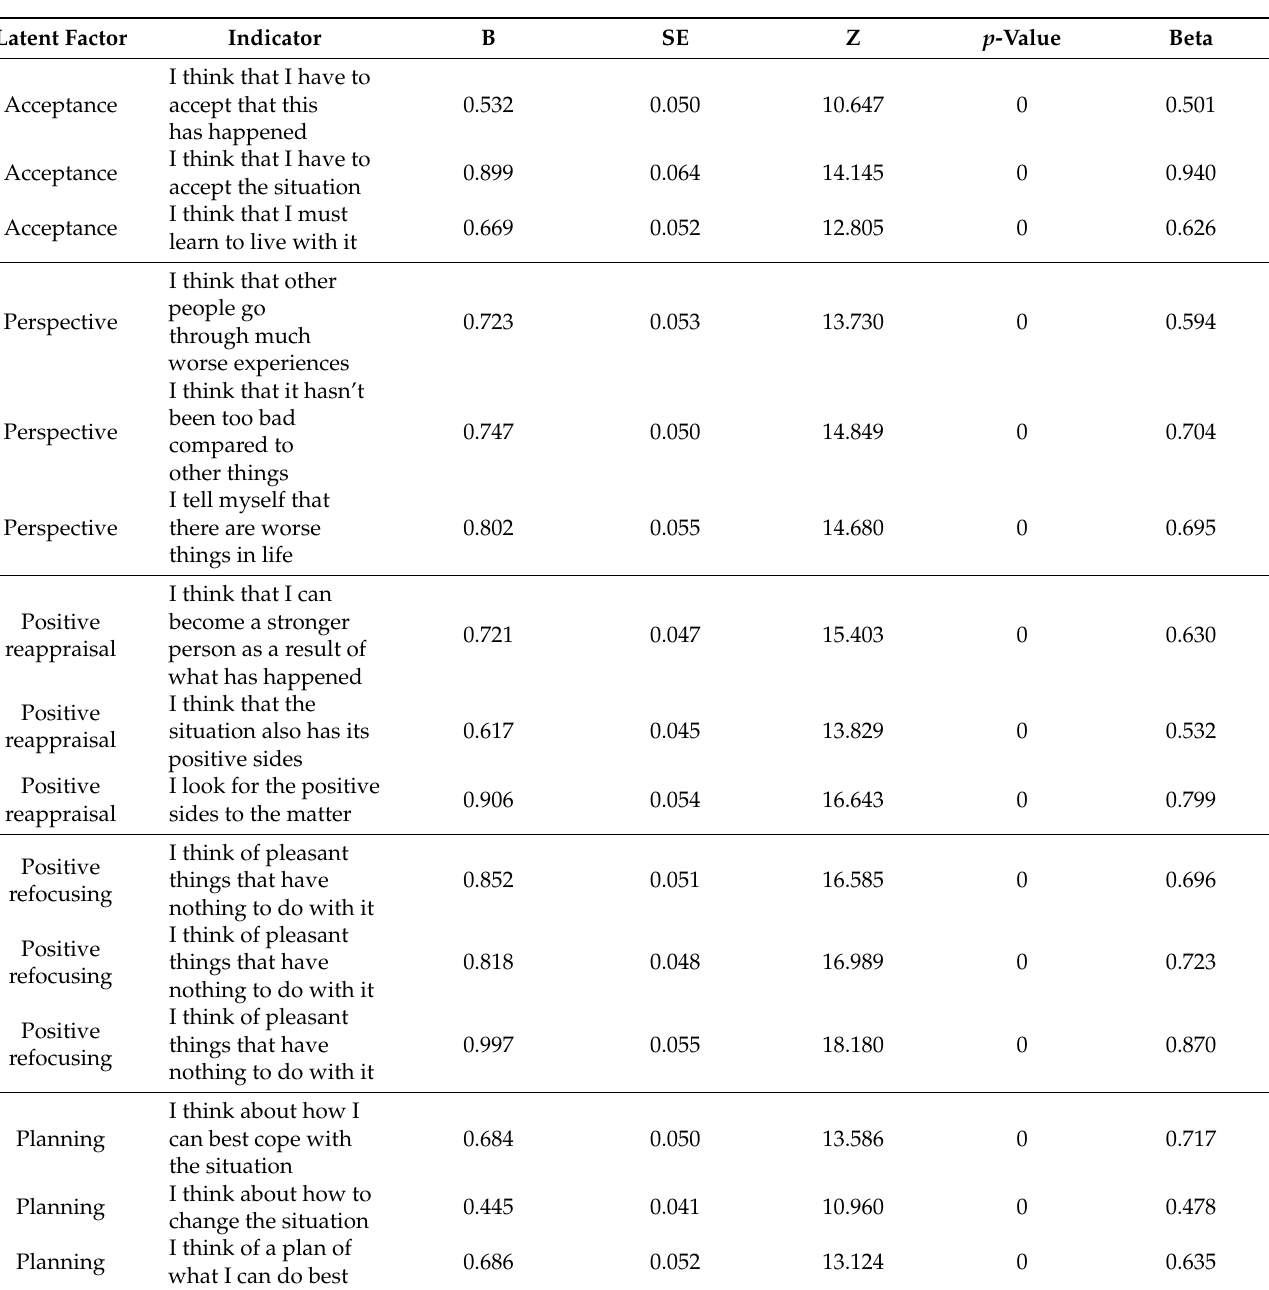
Table 3. Estimates of the nine-factor solution (adaptive